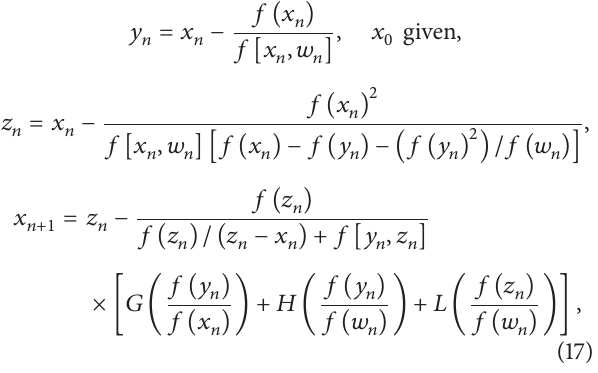
Figure 1: The distribution of